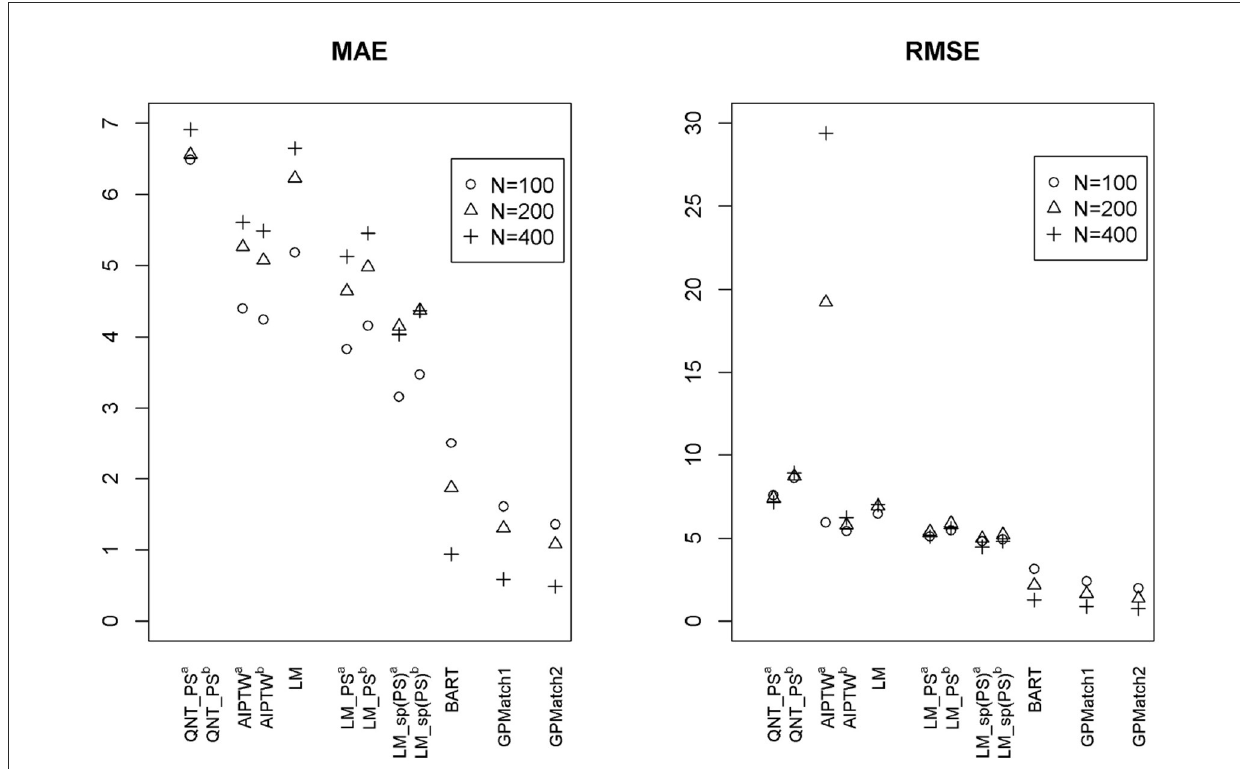
FIGURE5 The RMSE and MAE of ATE Estimates using Different Methods under the Kang and Shafer Simulation Study Setting. GPMatch1-2: Bayesian structural model with Gaussian Process prior. GPMatch1 including only the treatment effect, and GPMatch2 including both the treatment effect and X 1 − X 4 in the mean function; and X 1 − X 4 are included in the covariance function. QNT_PS, Propensity score sub-classification by quintiles; AIPTW, augmented inverse probability of treatment weighting; LM, linear regression modeling Y ∼ X 1 − X 4 ; LM_PS, linear regression modeling with propensity score